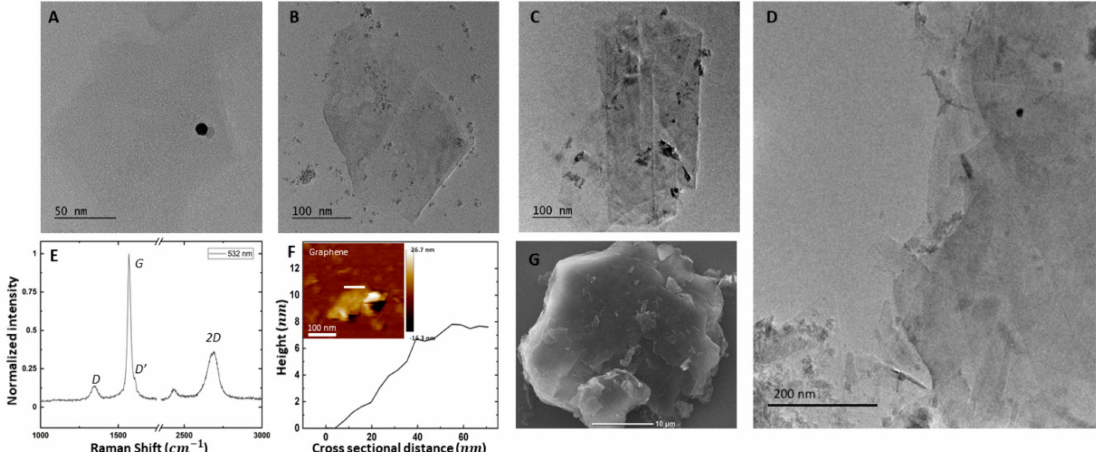
Figure 2. ( A ) Single graphene flake, which is semi-transparent; scale bar: 50 nm. ( B ) Transmission electron microscopy (TEM) image of a single few layer graphene (FLG), which is folded due to its large aspect ratio; scale bar: 100 nm. ( C ) Multiple graphene flakes with crumbled and folded morphology; scale bar: 100 nm. ( D ) TEM imaging demonstrates a distribution of flake sizes that tend to stack up; Scale bar: 200 nm. ( E ) Raman spectra of Graphene sample in 5 di ff erent laser spots. ( F ) Atomic force microscopy (AFM) image and corresponding height profile of graphene. ( G ) SEM Image of a Single Graphite particle; scale bar: 10 µ